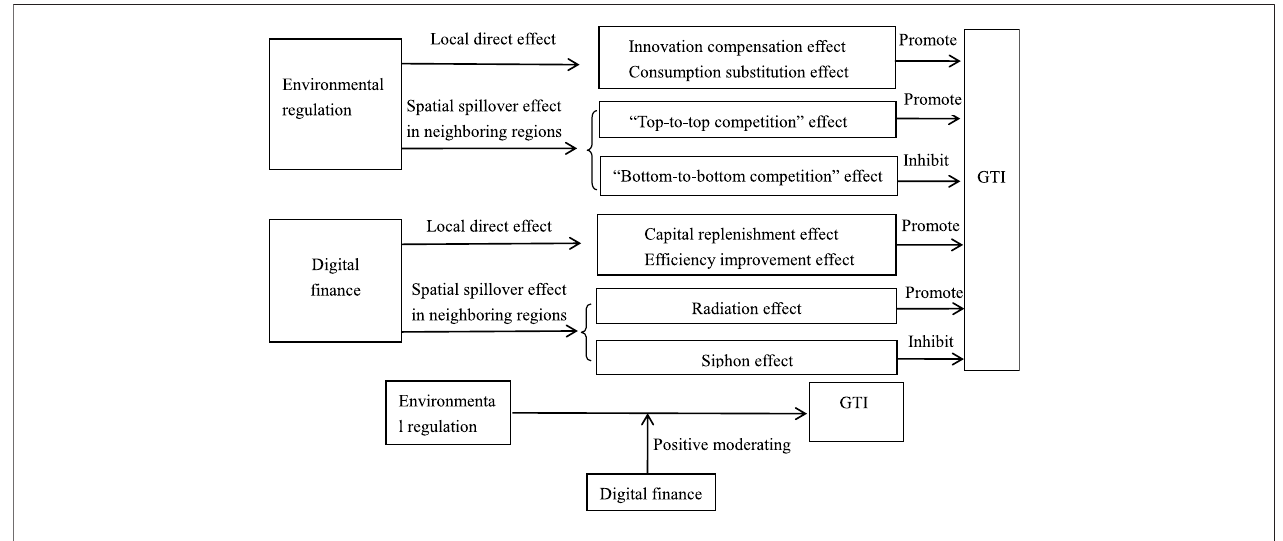
FIGURE 1 | Mechanism analysis